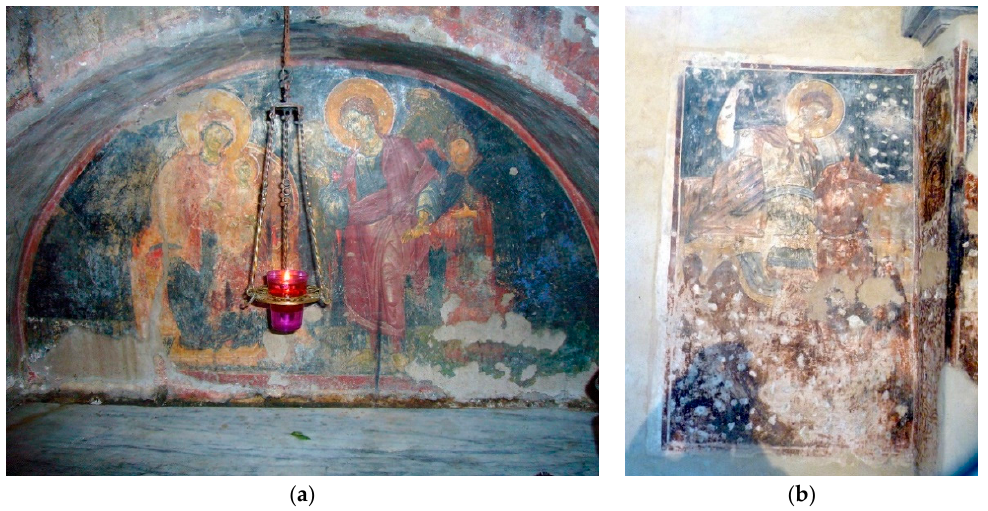
Figure 18. ( a ) Funerary portrait of sebastokrator Ioannes Angelos Komnenos Doukas, arcosolium esonarthex, Church of Porta Panagia (Thessaly), ca. 1283; © Used with permission of Anastasios Papadopoulos. ( b ) St George slaying the dragon (16th c. (?), Hagios Georgios in Akraifnio (Karditsa, Boeotia, Greece), north wall of the crossing. © Author with the permission of the Ephorate of Antiquities of Boeotia.